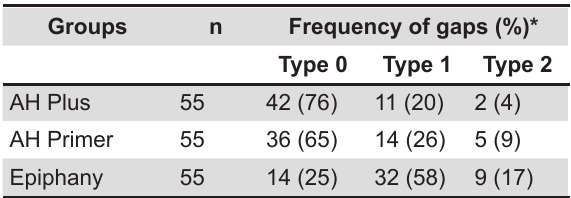
Table 1- Frequency and type of gaps in the apical 5 mm of root canal